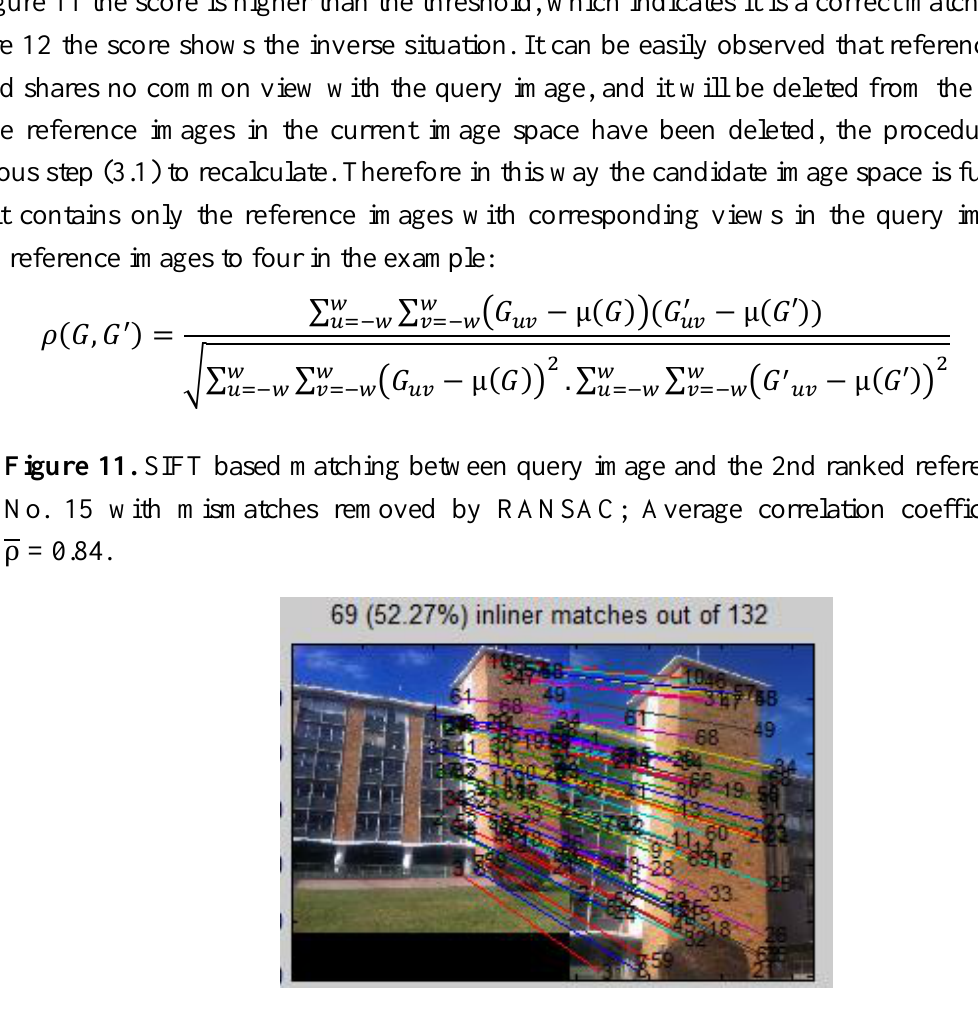
Figure 12. SIFT based matching between query image and 5th ranked reference image No. 17; Average correlation coefficient score =